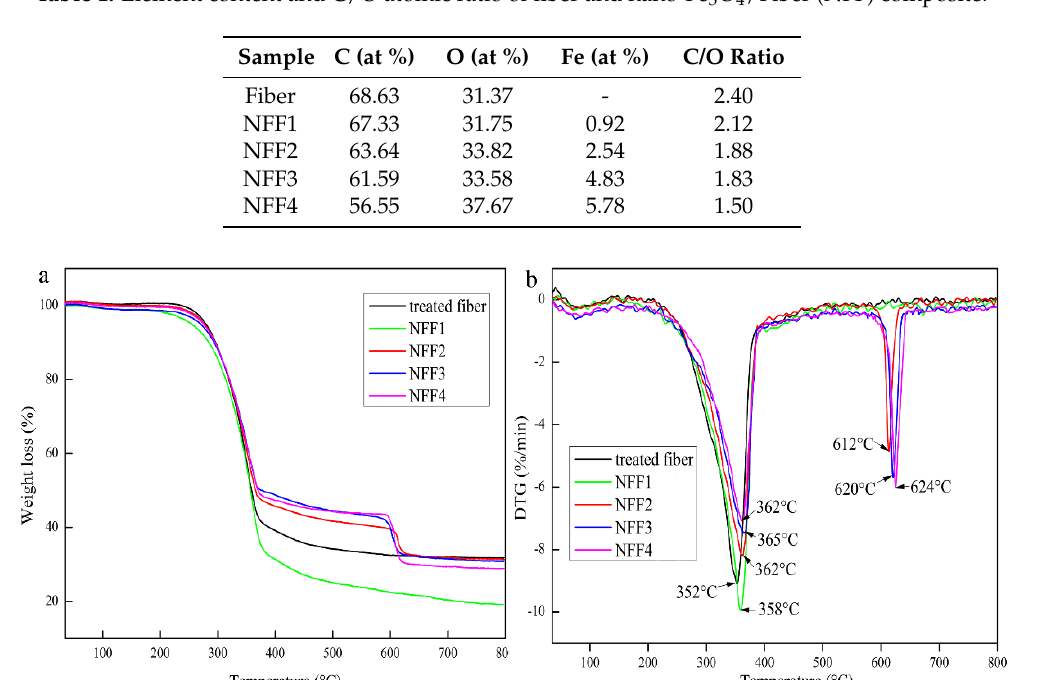
Figure 4. Thermogravimetric (TG) ( a ) and differential thermogravimetric (DTG) ( b ) curves of the fiber and NFF composites under an air atmosphere.